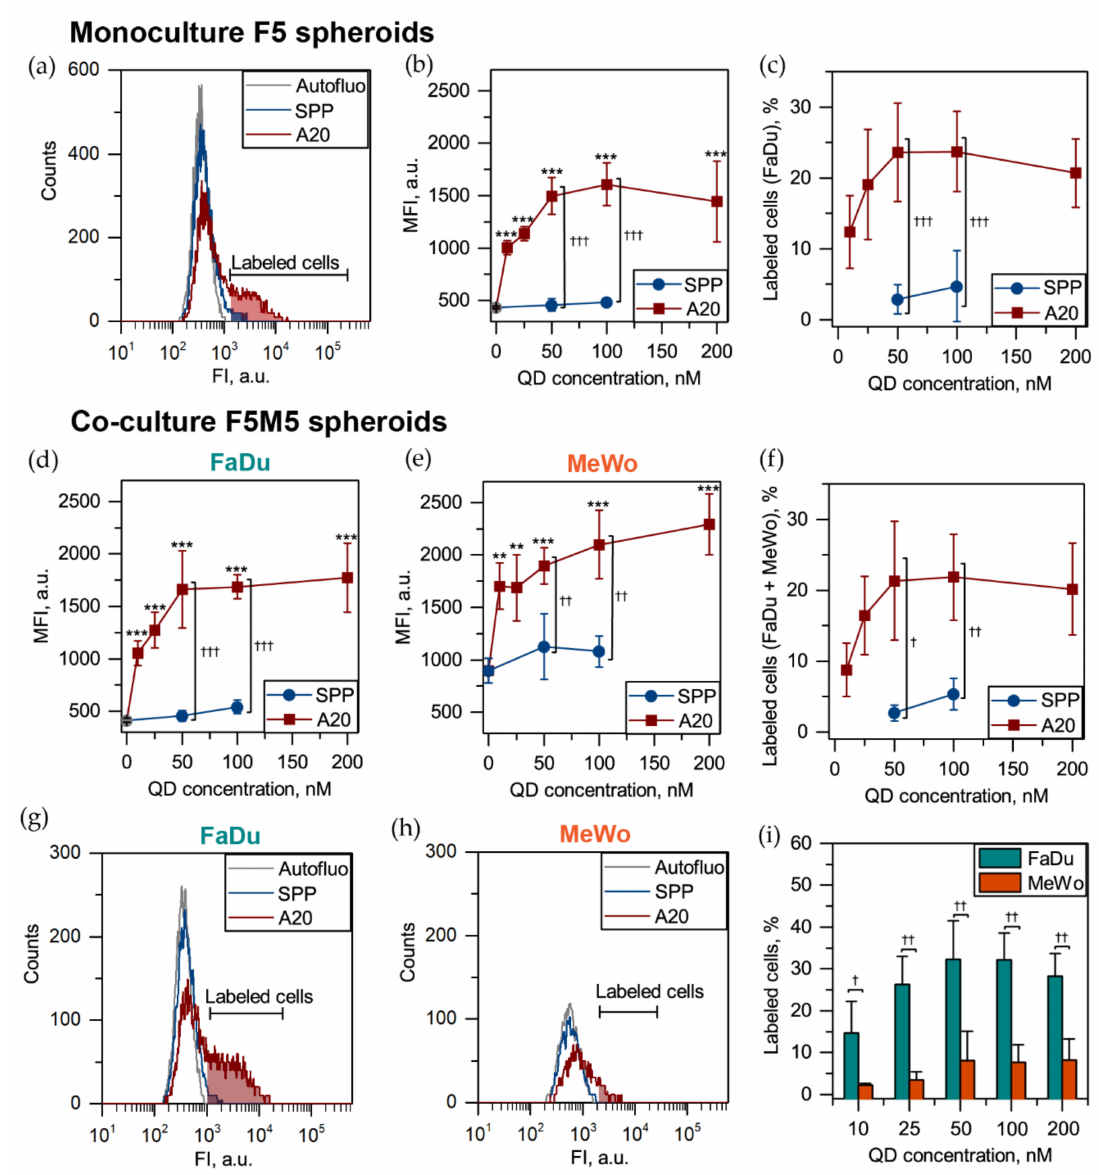
Figure 5. Uptake of QDs in 3D spheroids. ( a ) Flow cytometry histograms of cells from monoculture (F5) spheroids exposed for 3 h to 50 nM QD-SPP (blue) and A20-QDs (red). ( b ) The MFI and ( c ) the number of labeled FaDu cells in F5 spheroids exposed to various concentrations of QD-SPP (blue) and QD-A20 (red). MFI of ( d ) FaDu; ( e ) MeWo cells and ( f ) total number of labeled cells in F5M5 spheroids in the function of QD concentration. Typical flow cytometry histograms of ( g ) FaDu and ( h ) MeWo cells from F5M5 spheroids exposed for 3 h to 50 nM QD-SPP (blue) and A20-QDs (red). ( i ) The fraction of FaDu (cyan) and MeWo (orange) cells from F5M5 spheroids in the function of QD concentration. Data represent mean ± SD (n = 4–7; ** p < 0.01; *** p < 0.001 compared to autofluorescence, using ANOVA; † p < 0.05, †† p < 0.01 and ††† p < 0.001, using two-sample